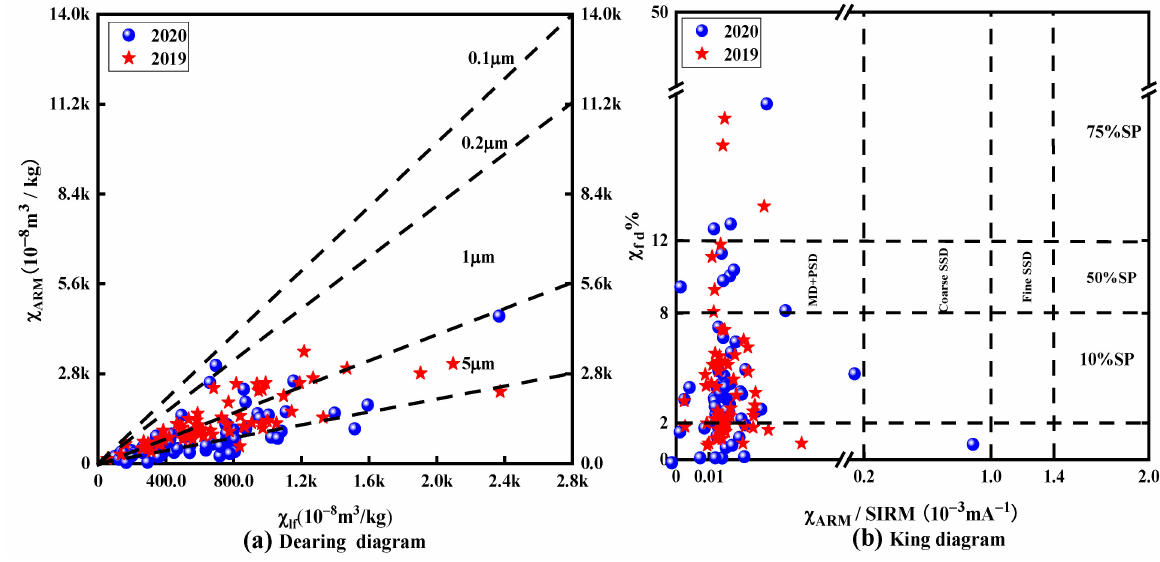
Figure 2. Dearing and King plot of dustfall